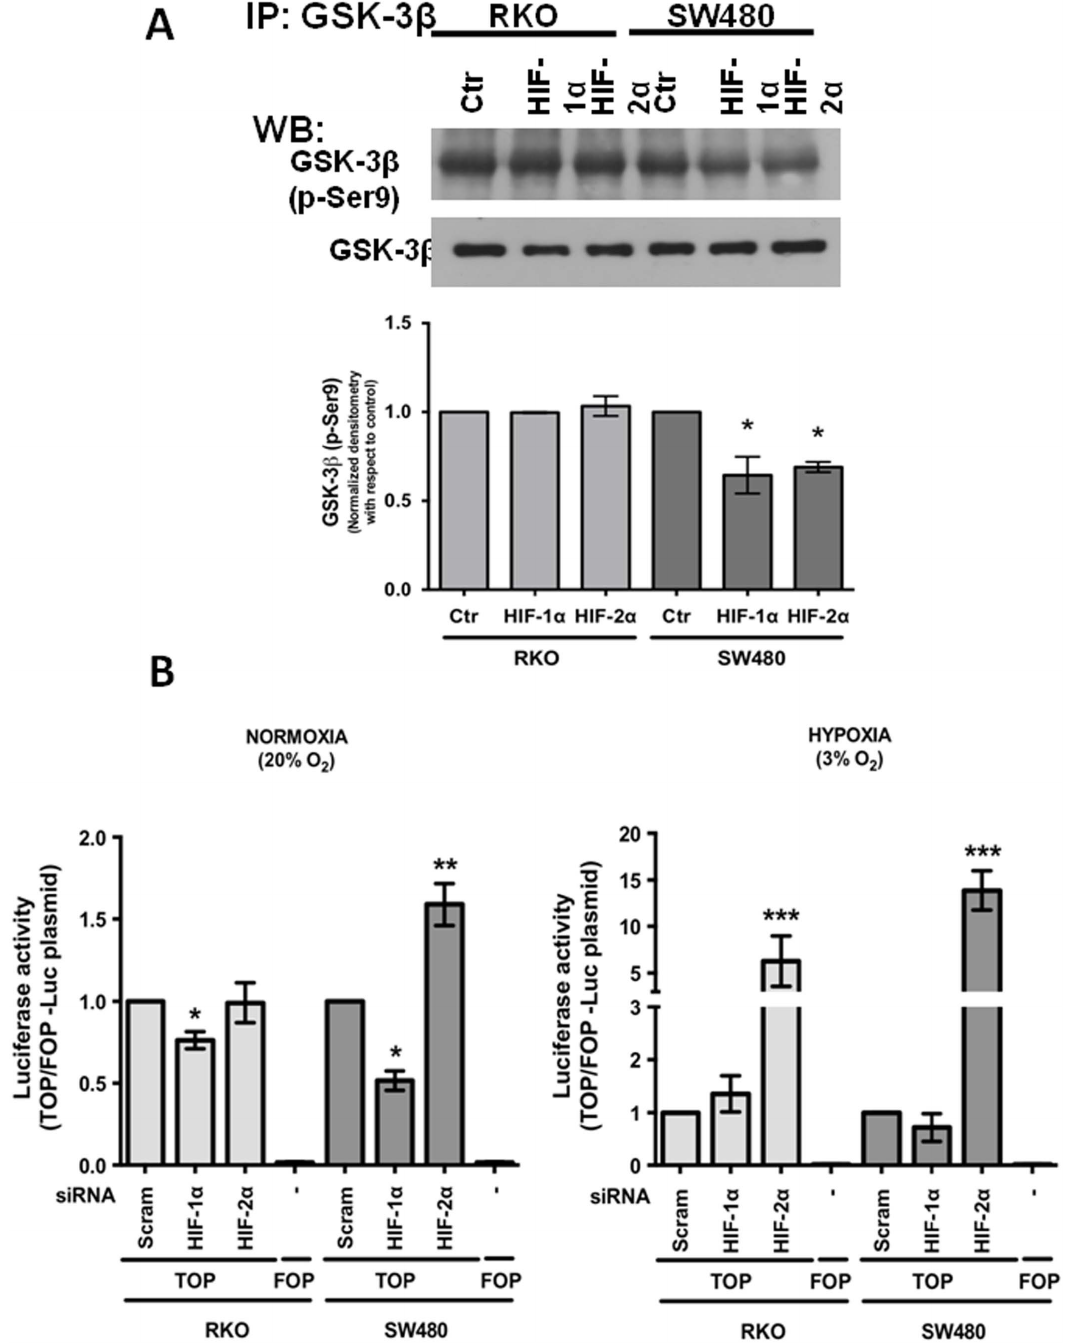
Figure 7. HIF-1 a and HIF-2 a knockdown produced opposite effects in canonical Wnt signaling. A) Stable HIF-1 a - or HIF-2 a -depleted cells exhibit decreased levels of the inactive (p-Ser9)-GSK-3 b form. Stable control (scrambled shRNA, Ctr in the figure) or HIF-1 a - or HIF-2 a -silenced RKO or SW480 colon cancer cells were cultured under normoxia. Total cell extracts of the colon cell lines were prepared, and the samples were subjected to 10% SDS-PAGE and transferred onto nitrocellulose membranes. An immunoblot analysis was performed using anti-GSK-3 b or anti-(p-Ser9)-GSK-3 b , as indicated in the figure, and developed using a horseradish peroxidase-conjugated second antibody. Densitometric analysis was performed to estimate the level of (p-Ser9)-GSK-3 b with respect to the level of total GSK-3 b . All of the assays were performed in triplicate, and the data represent the means 6 SEM from at least three independent assays. *: p , 0.05. B) Stable control (scrambled shRNA, ‘‘Scram’’ in the figure) or HIF-1 a - or HIF-2 a - silenced SW480 or RKO cells were transiently transfected with the pTOPFlash or pFOPFlash (control) reporter plasmids. At 24 h post-transfection, the cells were incubated under normoxic (20% O 2 ) or hypoxic conditions (3% O 2 ) for 12 h. The cells were washed and lysed, and the luciferase activity was assayed. The activity was normalized with respect to the activity of Renilla luciferase or with respect to the protein content in each sample. All of the assays were performed in quintuplicate, and the data represent the means 6 SEM from at least five independent assays. *: p , 0.05; **: p , 0.01; ***: p , 0.001.